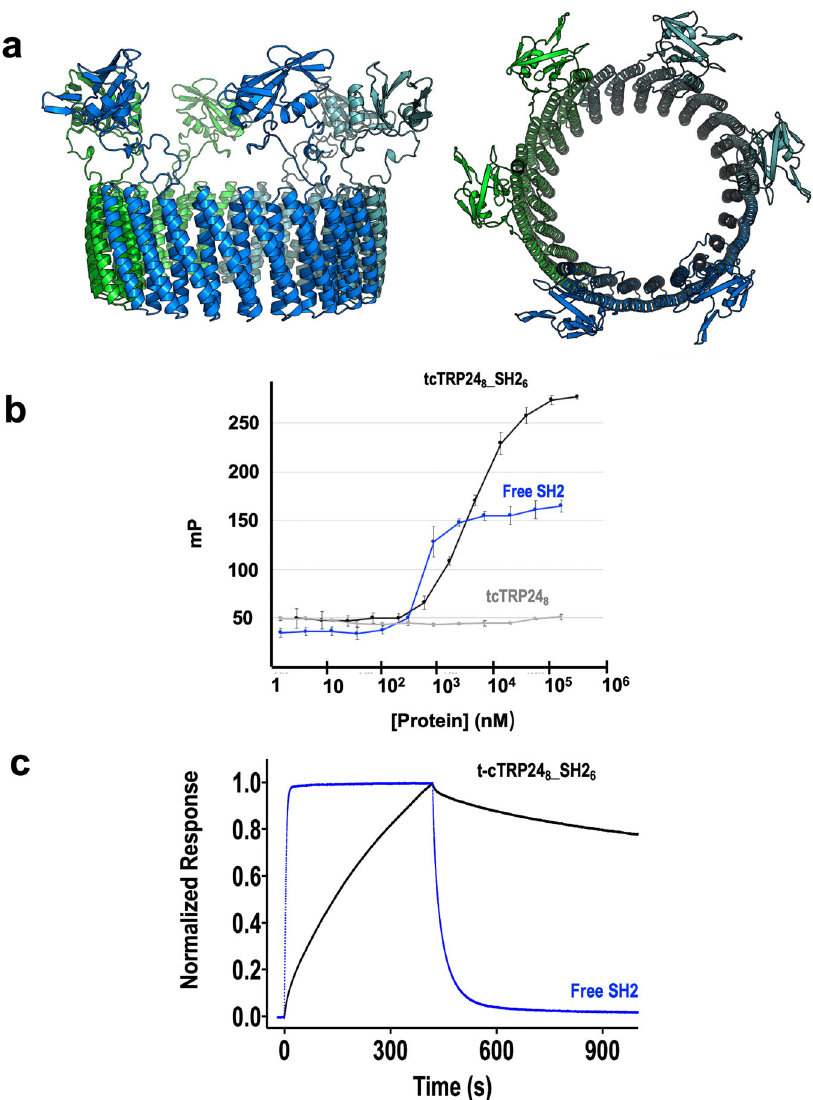
Fig. 7 Peptide binding function of tcTRP24 8 SS_SH2 6 in solution and on a surface. a Schematic model of the construct shown in two orientations. Two copies of the SH2 domain are fused into a loop (between repeats 2 and 3, and between repeats 6 and 7) in each of three subunits, resulting in the presence of six domains distributed around the periphery of the construct in a hexagonal arrangement. b Binding of fl uorescently labeled Tir10 phosphotyrosyl peptide (corresponding to the physiological binding target for the Nck SH2 domain) was measured in solution using fl uorescence polarization. Binding activity was measured using isolated SH2 domain (blue), and tcTRP24 8 -SH2 2 (a tcTRP trimer containing two copies of fused SH2 domains per subunit, i.e., six copies total; black). A control experiment was also conducted using the free ‘ naked ’ tcTRP24 8 (gray) that contained no functional protein domains. The protein concentration is normalized to account for the ratio of SH2 domains per molecule (6 SH2 domains per tcTRP 8 _SH2 2 versus 1 per free SH2). Both constructs display saturable binding and an approximate K D of 1 − 3 micromolar. All binding experiments were conducted in triplicate using independent aliquots of each protein. Data shown as mean and standard deviation for n = 3 measurements. c Binding and dissociation of free SH2 (blue) and cTRP24 8 - SH2 2 (black) to surface-bound peptide. Surface Plasmon Resonance ( ‘ Biacore ’ ) was used to measure the binding to captured biotinylated phosphotyrosyl peptide as described in